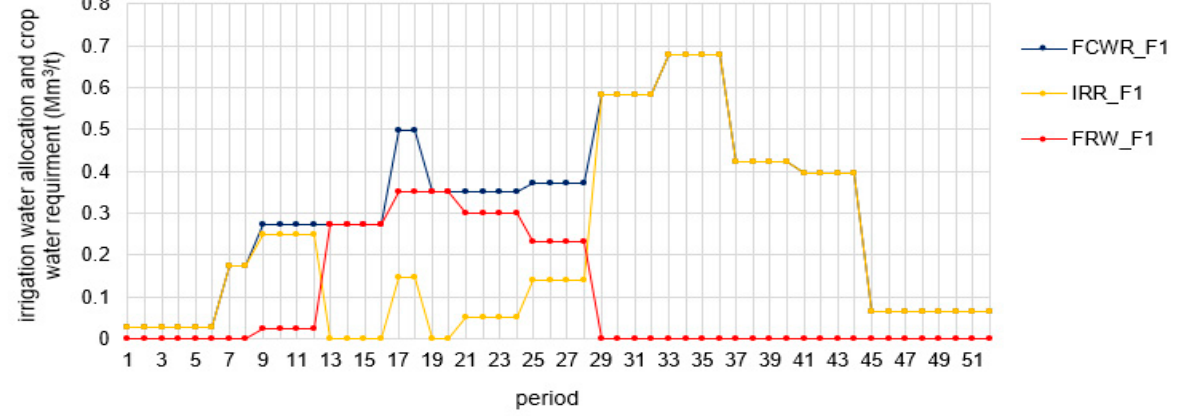
Figure 16. Allocated irrigation water (orange), crop water requirement (blue), and available rainfall (red) for farm 1 (Omo-Gibe River basin) (Mm 3 /week).